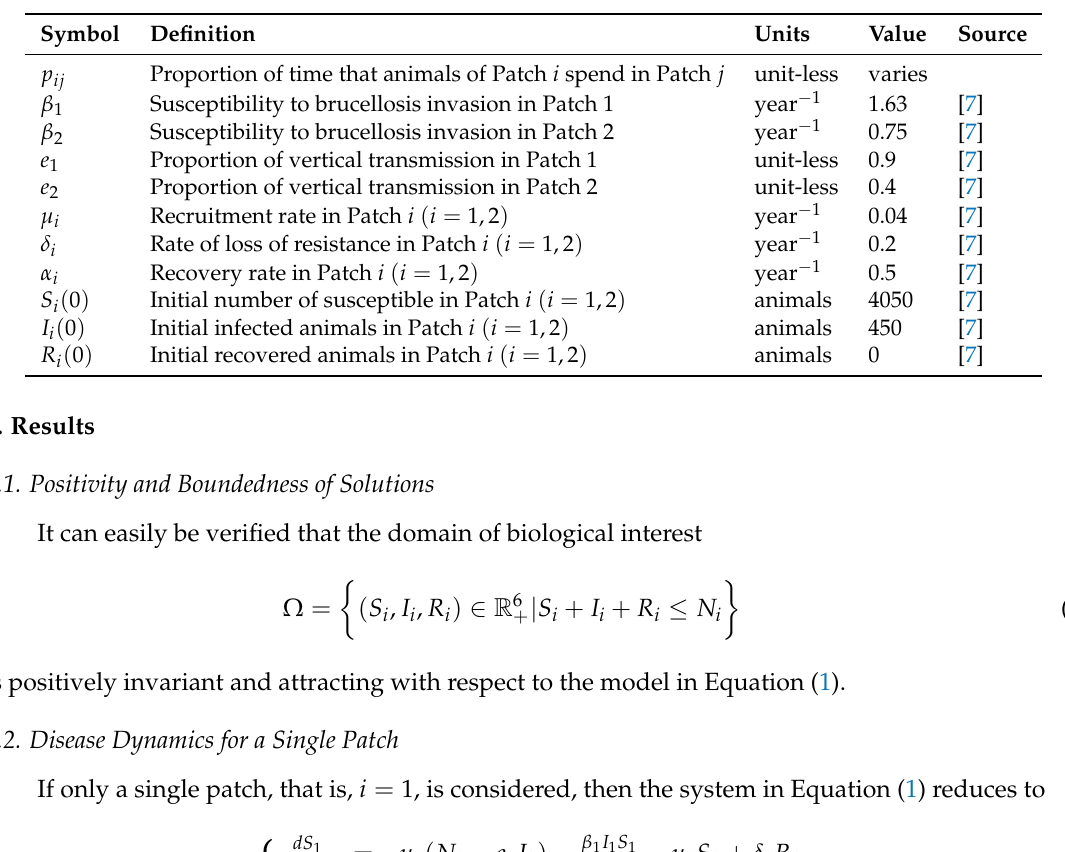
Table 1. Parameters and